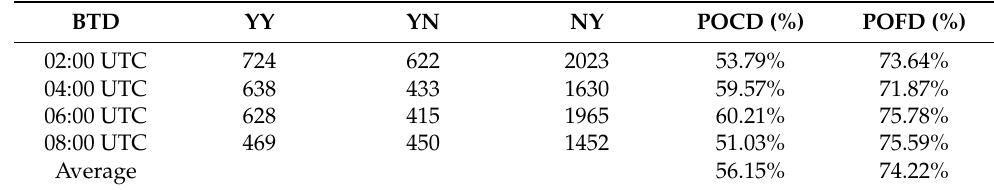
Table 3. Statistical metrics for the comparison of the BTD dust identification and the PM10 observations.